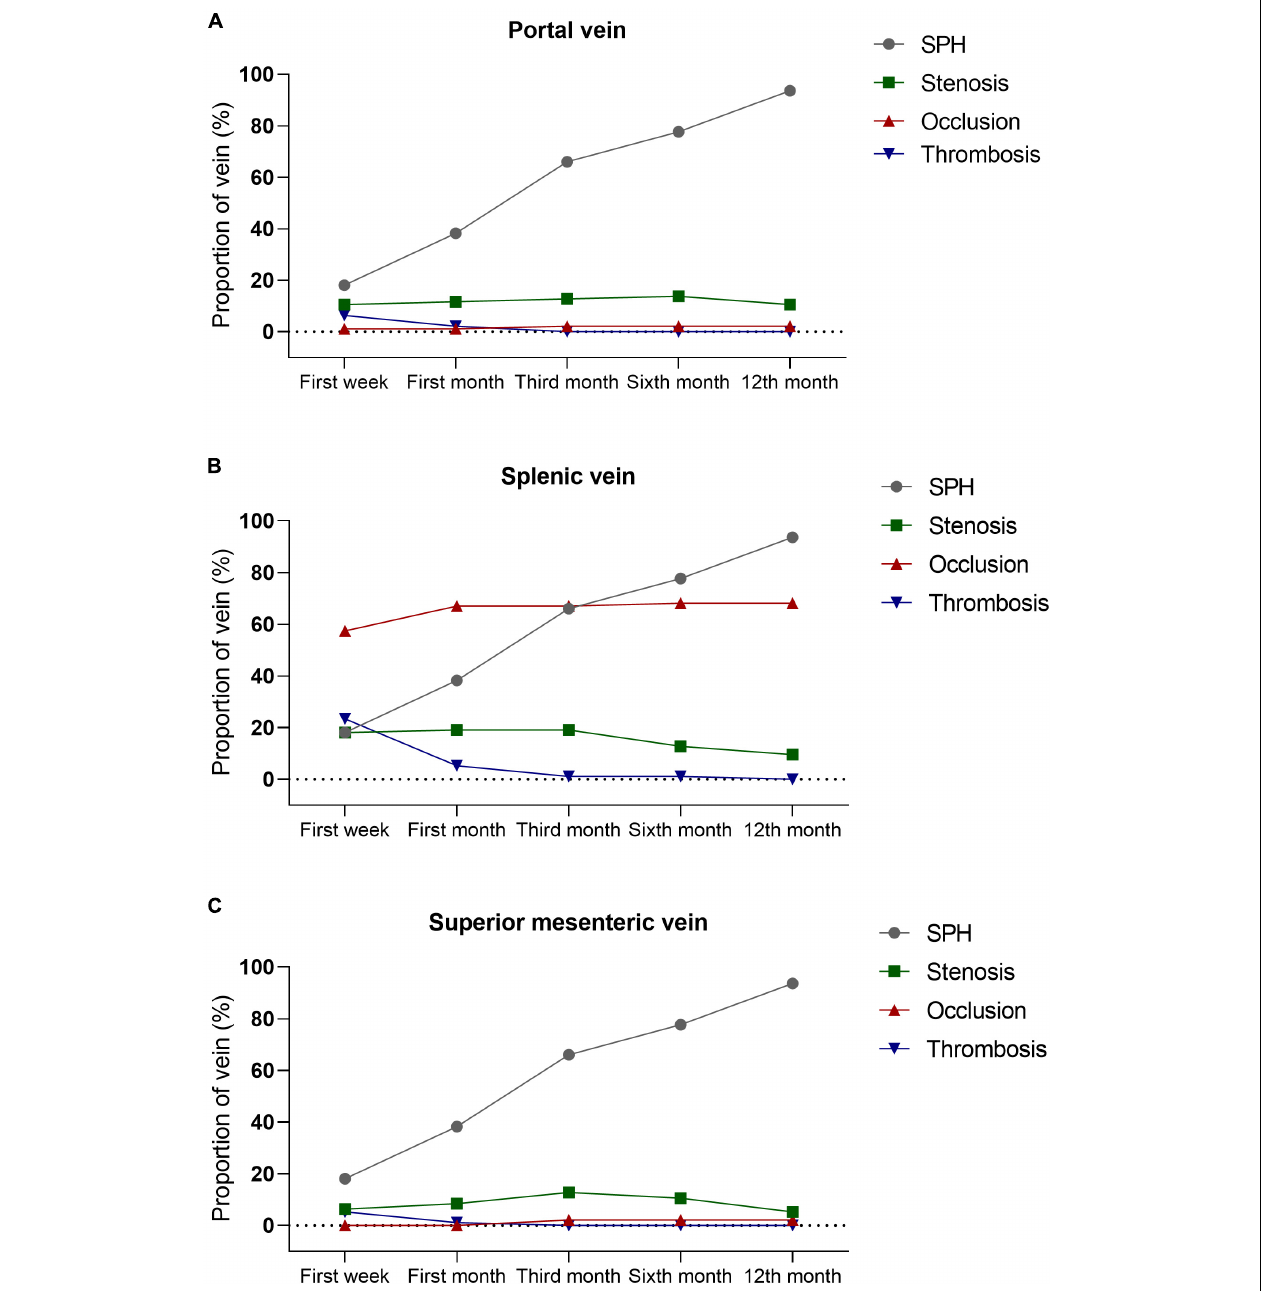
FIGURE 3 | The Patency of portosplenomesenteric veins and their association with SPH. Thrombosis of portal vein (A) , splenic vein (B) , and superior mesenteric vein (C) are usually detected within 1 month after the onset of AP and undetected 3 months after the onset of AP. Unlike thrombosis, stenosis and occlusion of portosplenomesenteric vein tend to appear at the early stage of disease and persist during the one-year follow-up period. SPH, sinistral portal hypertension; AP, acute pancreatitis.